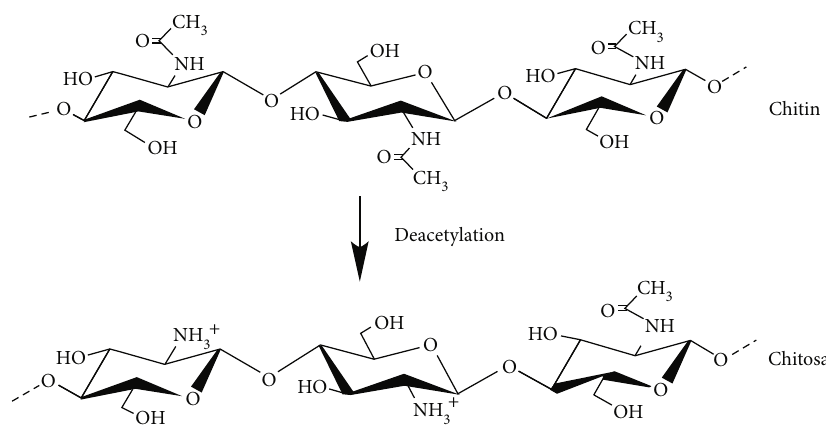
Figure 2: Deacetylation of chitin to